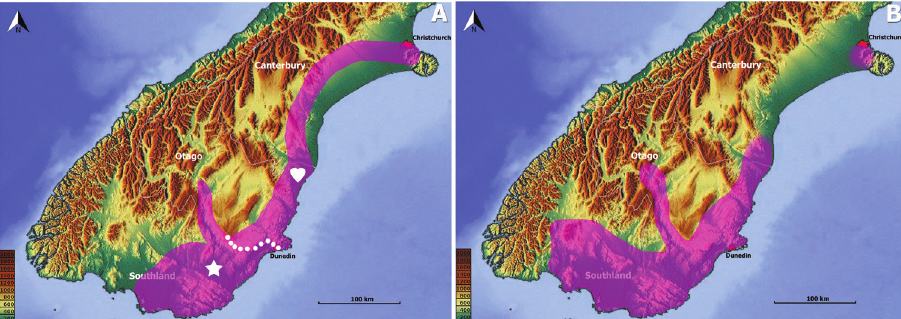
Figure 10. Map of southern half of South Island, New Zealand, showing ranges of subterranean non- montane Anillina. A – Zeanillus (combined ranges of subgenera Zeanillus s. str. (heart) and Brounanillus (star), white dots represent approximate boundary between taxon ranges); B – Pelodiaetus . Elevation scale bars are given in